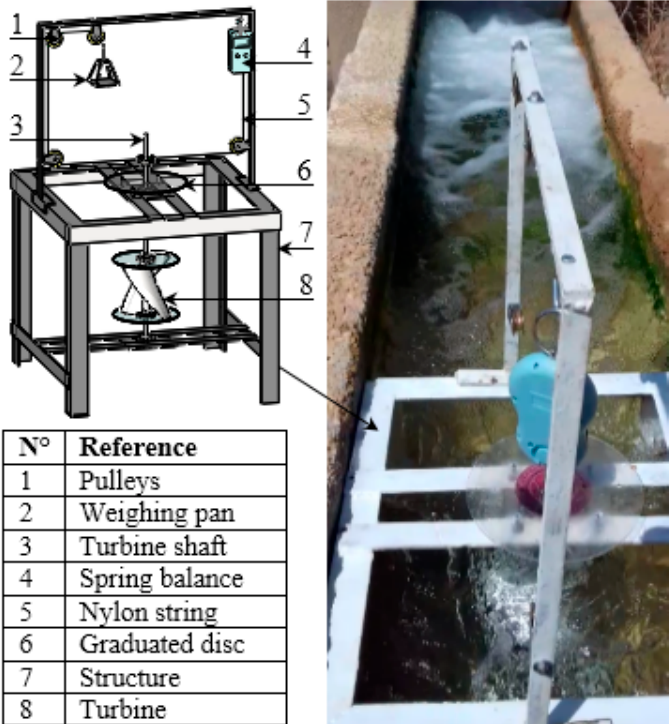
Figure 4. Schematic diagram of the experimental setup.